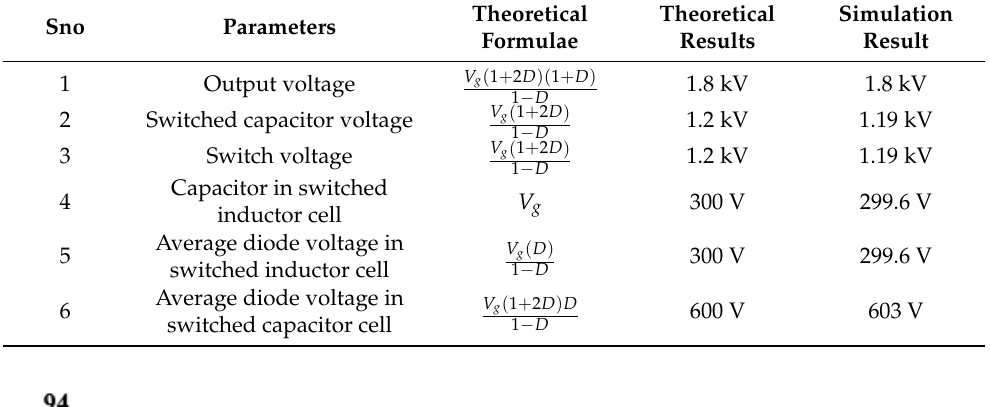
Table 7. Comparison of simulation and theoretical results.